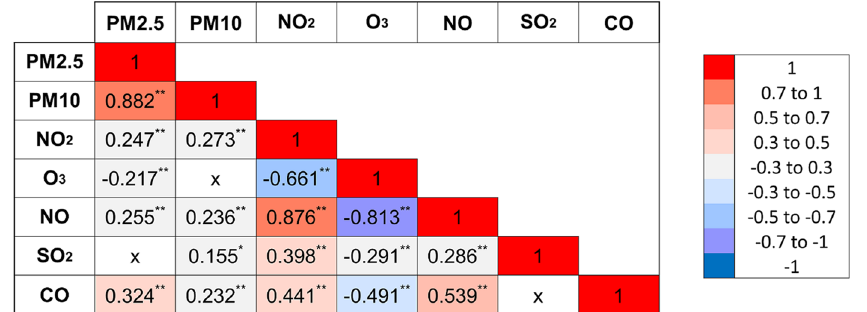
Figure 1. Correlation map of air pollutants. **Correlation is significant at the 0.01 level. *Correlation is significant at the 0.05 level. X no significant